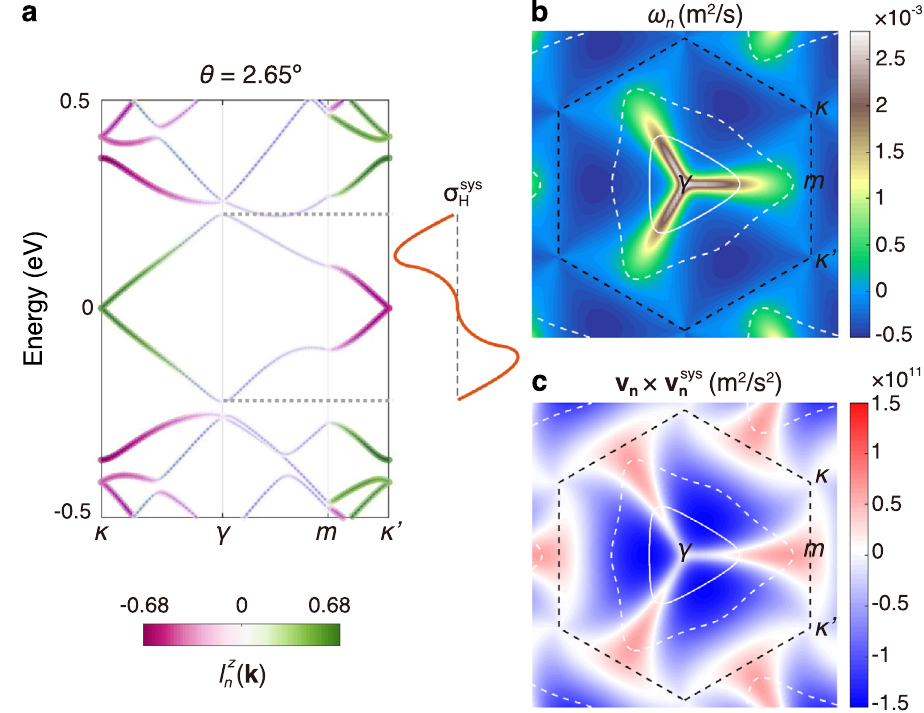
Fig. 3 | Understanding the TR-even Hall effect from band geometric quantity. a Band structure, b layer current vorticity ω n , and c ð v n × v sys n Þ z of the fi rst con- duction band from +K valley of 2.65 ∘ tBG. In a , the color coding denotes the layer